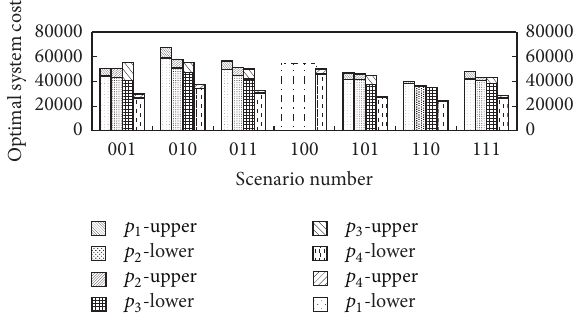
Figure 5: Optimal costs under high contaminant ingression/gene- ration level.